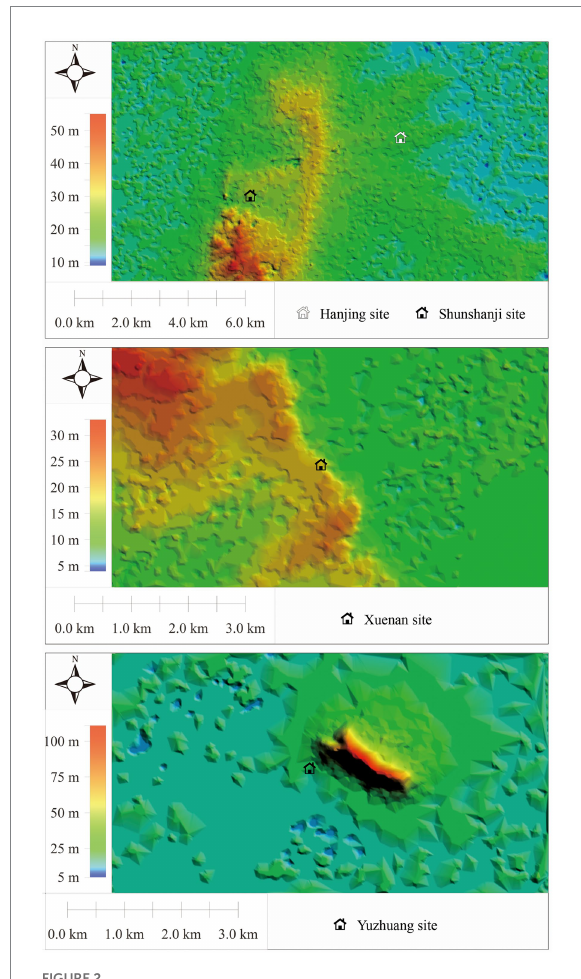
FIGURE 2 Elevation grid of the Shunshanji cultural settlements.